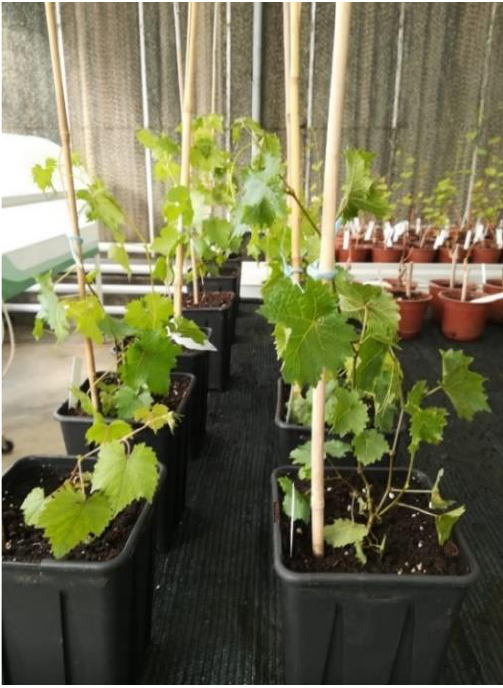
Figure 4. Acclimatized plants cultivated in pots in the greenhouse.